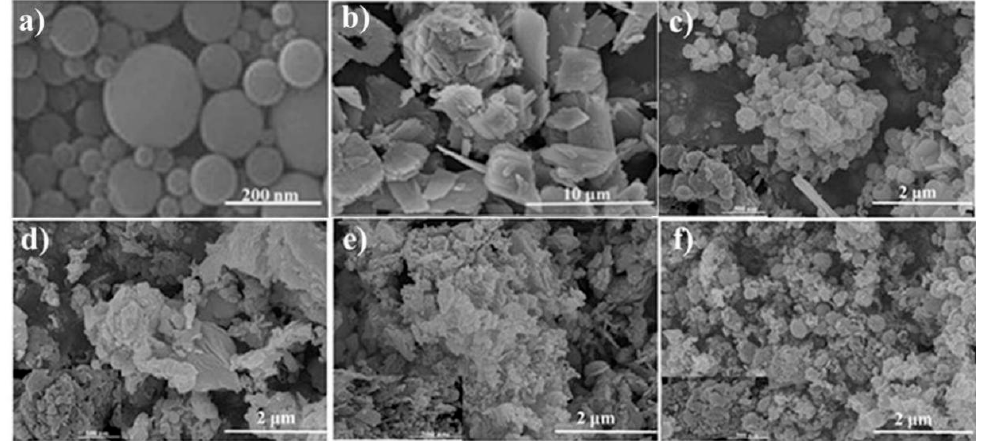
Figure 2. SEM images of LC/ZnO ( a ) QAL; ( b ) ZnO; ( c ) LC/ZnO-450 °C (inset: SEM image of 500 nm); ( d ) LC/ZnO-500 °C (inset: SEM image of 500 nm); ( e ) LC/ZnO-550 °C (inset: SEM image of 500 nm); ( f ) LC/ZnO-600 °C (inset: SEM image of 500 nm).